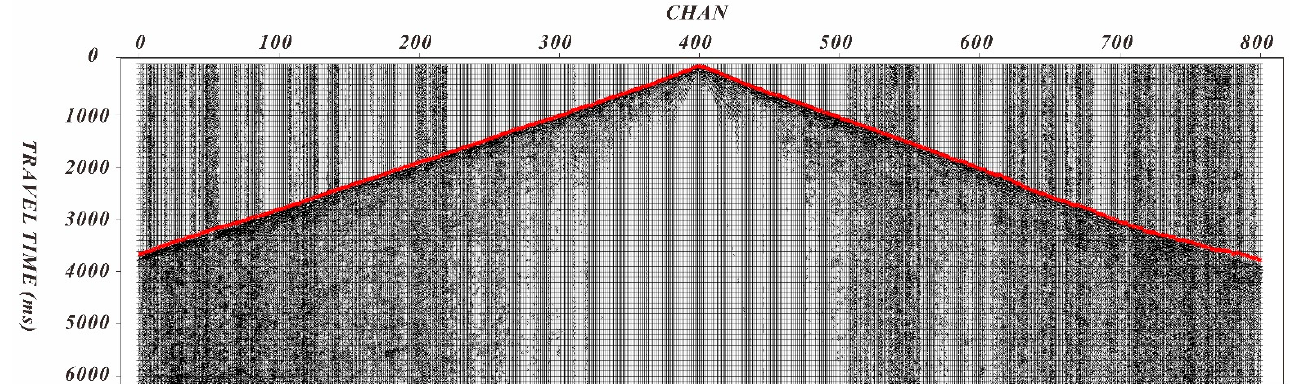
Figure 4. Example of first ‐ arrival travel time picking (Red line represents the picked first ‐ arrival travel time). The position is shown in Figure 1B with Typical